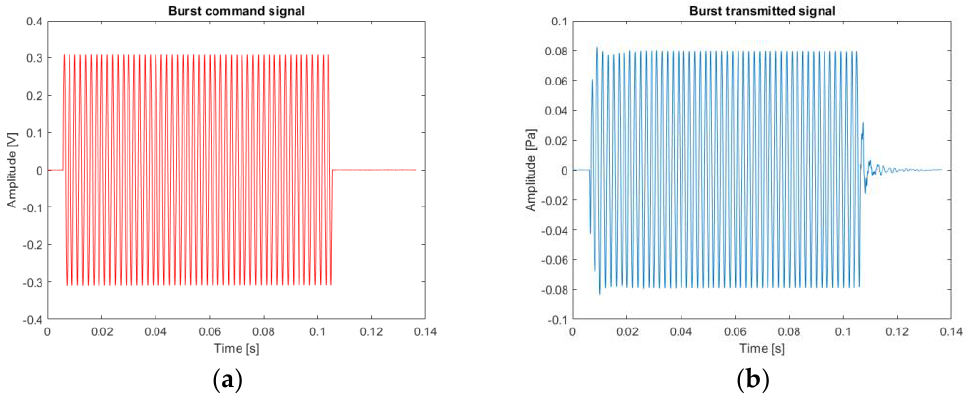
Figure 9. Example of the loudspeaker response (burst of 100 ms at 500 Hz): ( a ) theoretical source